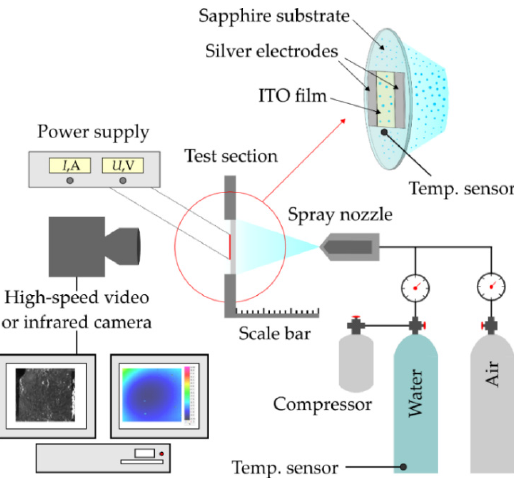
Figure 1. Schematic view of the experimental setup and the test section.